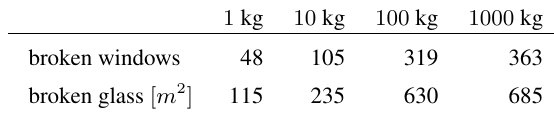
Table 3. Number and glass area of broken windows in each scenario of a total of 367 windows detected around the